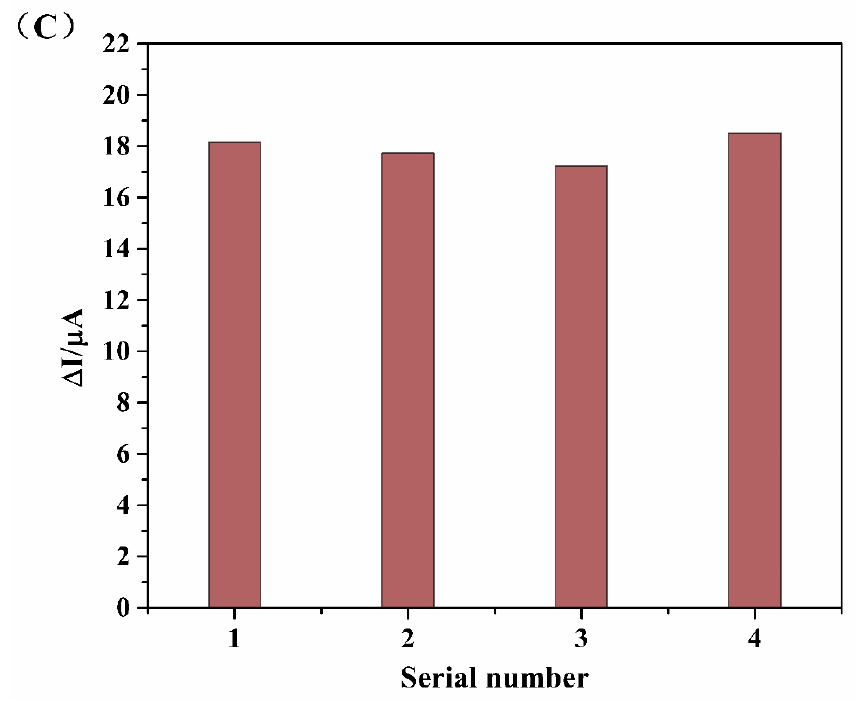
Figure 6. ( A ) Specificity of aptasensor; ( B ) stability of aptasensor; ( C ) reproducibility of aptasensor.